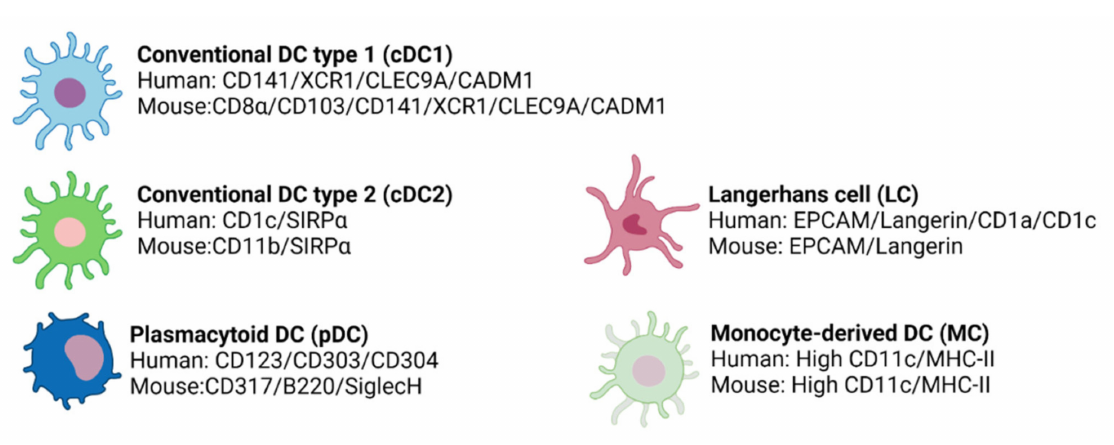
Figure 5. The different DC subtypes express specific surface markers in humans and mice.